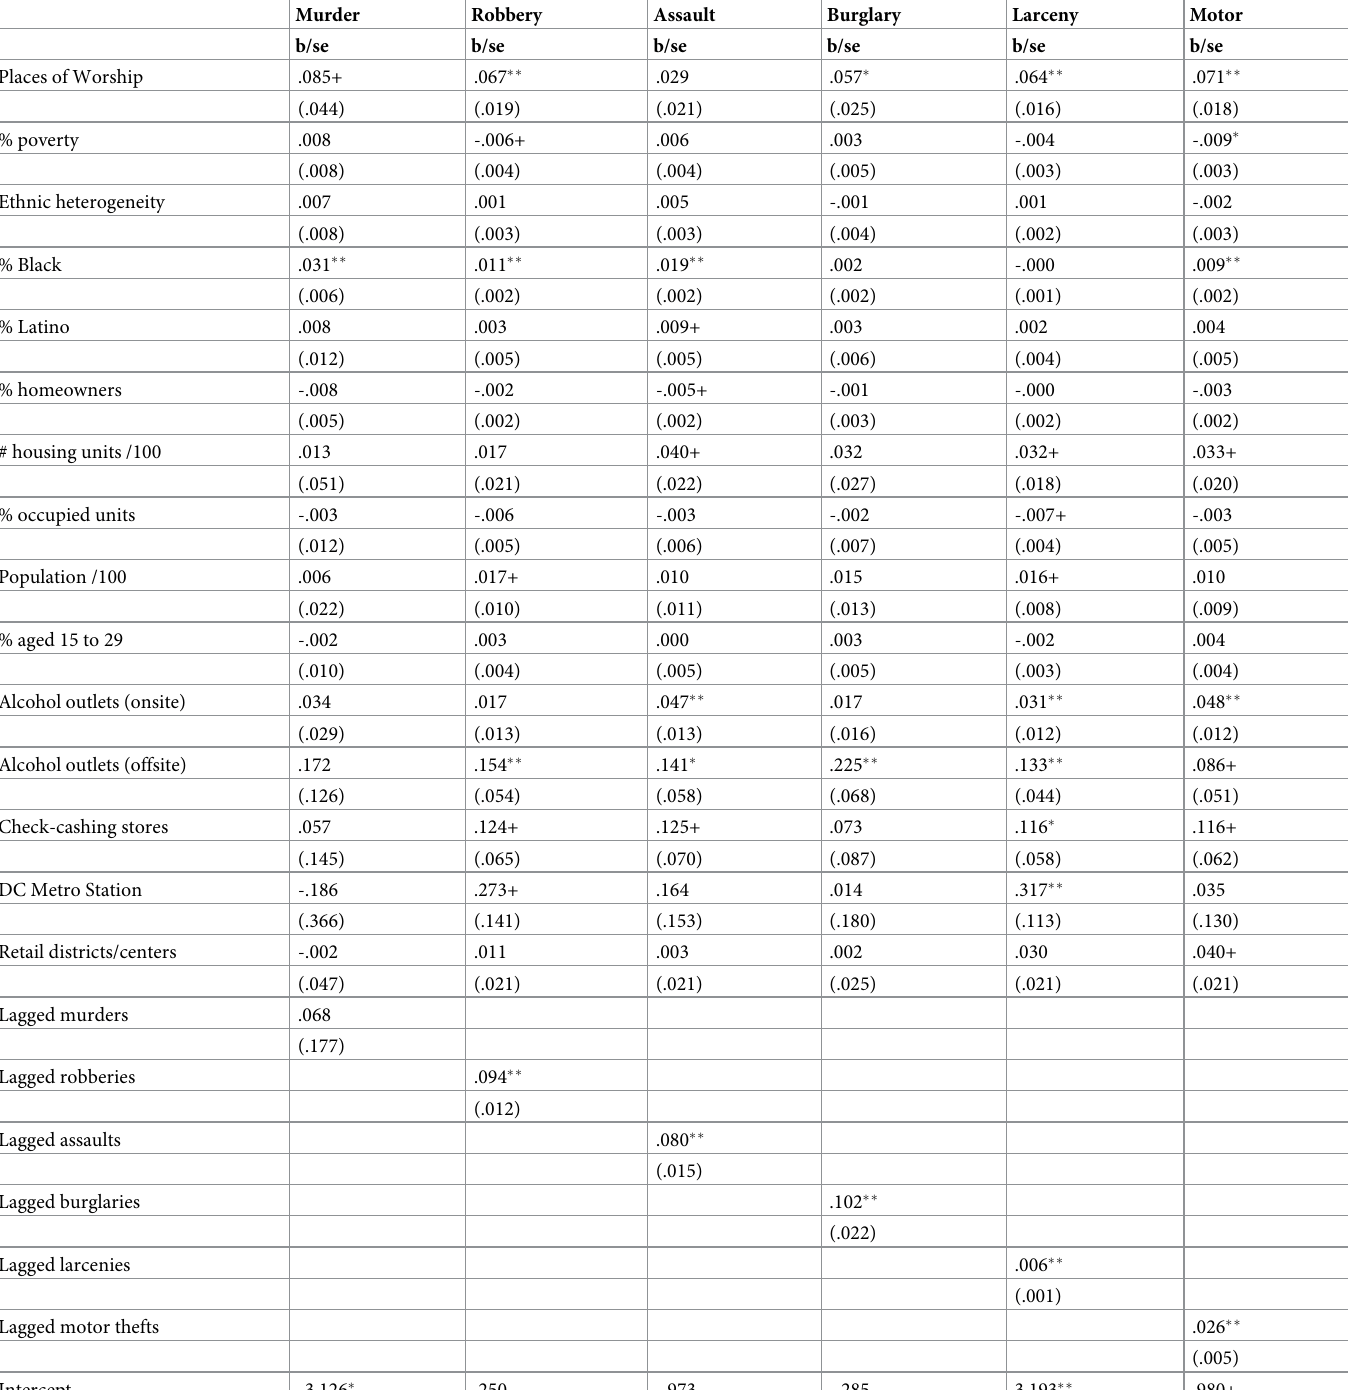
Table 5. Negative binomial regression: POW effects on neighborhood crime.